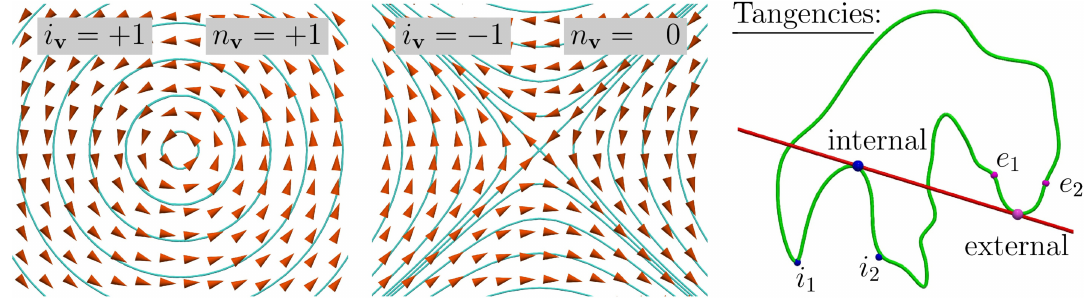
Figure 1 . Phase portraits that are encountered in the present study of the superflow velocity vector v ( x ) in eq. (2.1). The red arrows show the vector field v ( x ) , and the cyan lines represent its streamlines. The first two panels, respectively, show a center that corresponds to a single vortex core with n v = 1 and i v = 1 , and a saddle that corresponds to a stagnation point with n v = 0 and i v = − 1 . The rightmost panel illustrates what are internal and external tangencies. Since the curve segment between i 1 and i 2 is concave, it ads one to I Γ . Likewise, the curve segment between e 1 and e 2 is convex and it ads one to E Γ . It is notable that both centers and saddles appear in the common description of Kosterlitz-Thouless theory of phase transitions in the 2D XY model. In that model vortex cores appear topologically as centers and antivortex cores appear as saddles, and both have an energy that diverges logarithmically when the short distance cutoff goes to zero [37] (see